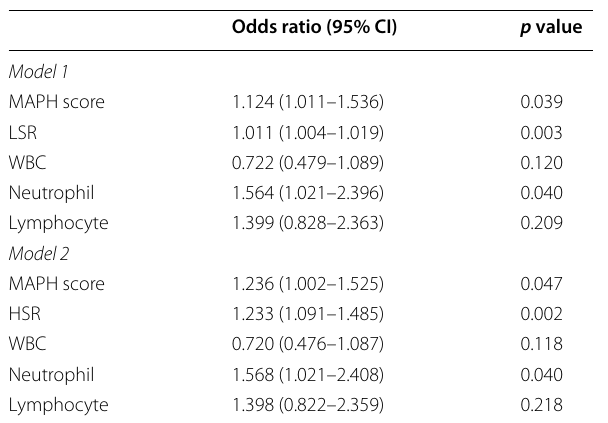
Table 3 Multivariate logistic regression analysis for prediction of high thrombus burden